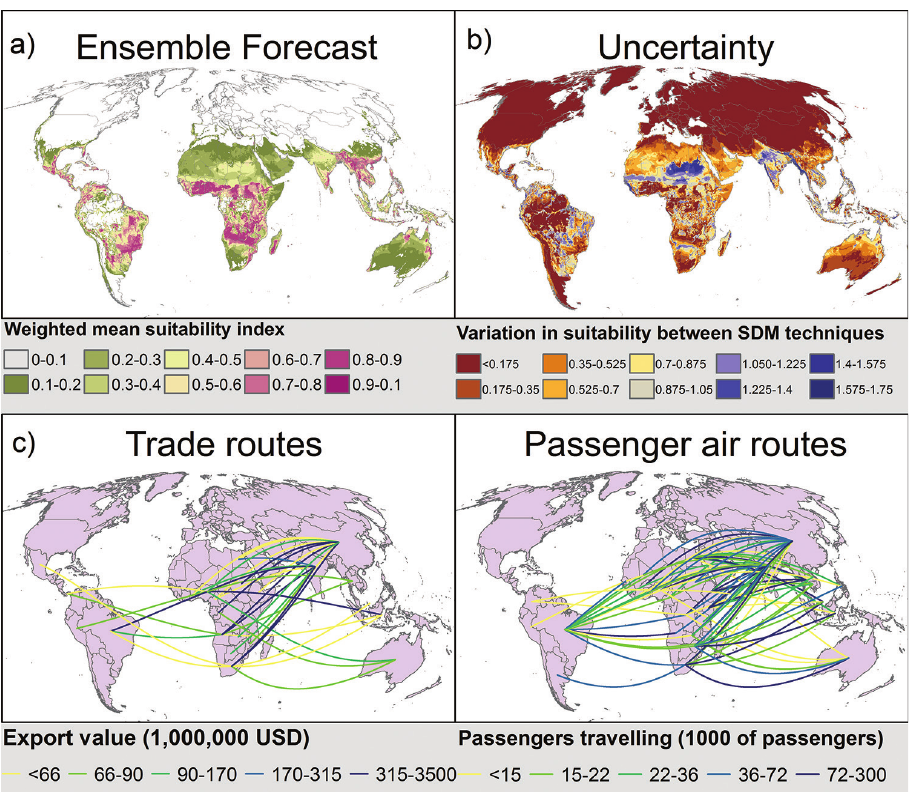
Figure 4. Global suitability for fall armyworm and likely invasion routes. a Potential global distribution of fall armyworm, as predicted by an ensemble of SDMs constructed using all distribution data and with four pseudo-absence datasets. SDMs were permitted into the ensemble if the TSS from internal cross-validation was ≥0.4. The ensemble was calculated as the mean of projections from all permitted SDMs, each model weighted by the cross-validated TSS b uncertainty in projections, as calculated by the variation between all projections included in the ensemble c value of all exports from 2012–2016 from source sub-Saharan African countries climate to vulnerable countries outside sub-Saharan Africa. The top 5% of trading rela- tionships between these countries are shown and the five colour categories represent 20% quantiles of export values d number of passengers in 2013 travelling from source sub-Saharan African countries with their final destination in vulnerable countries outside sub-Saharan Africa. The top 13% of travel routes between these countries are shown and the five colour categories represent 20% quantiles of passenger